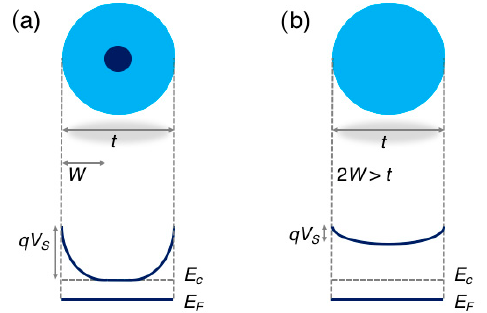
Figure 2. Schematic representation of the energy band diagram in a spherical grain of diameter t in the regional depletion regime ( a ), in which the grain diameter is larger than two times the depletion layer W (t > 2W), and in the volume depletion regime ( b ), in which 2W > t. Adapted with permission from [40]. Copyright (2018) American Chemical Society.